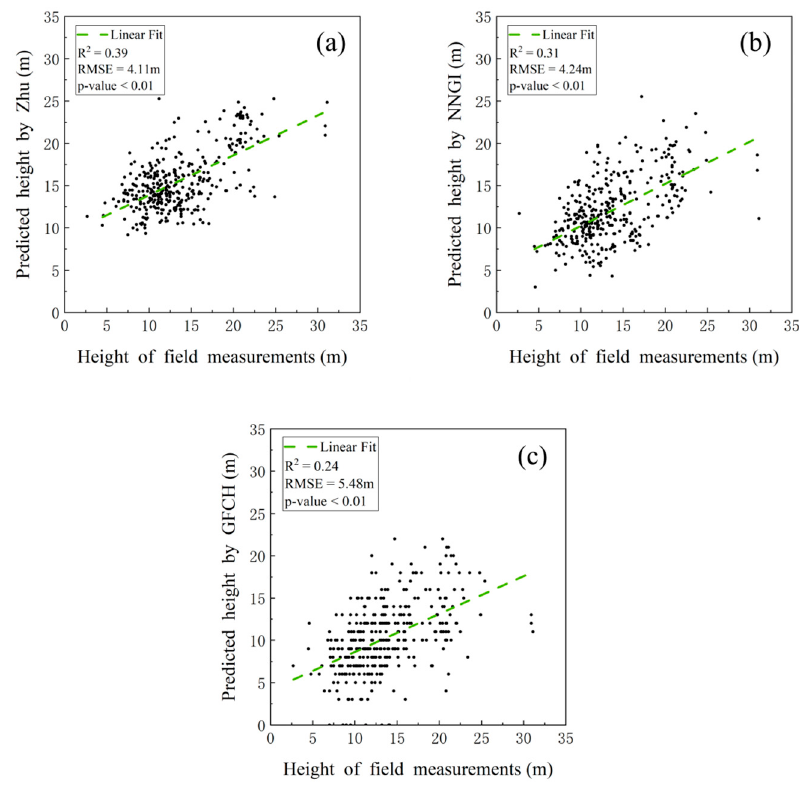
Figure 9. Validation of the forest height of Jiangxi Province generated by ( a ) Zhu [18], ( b ) NNGI [50], ( c ) GFCH [25] .